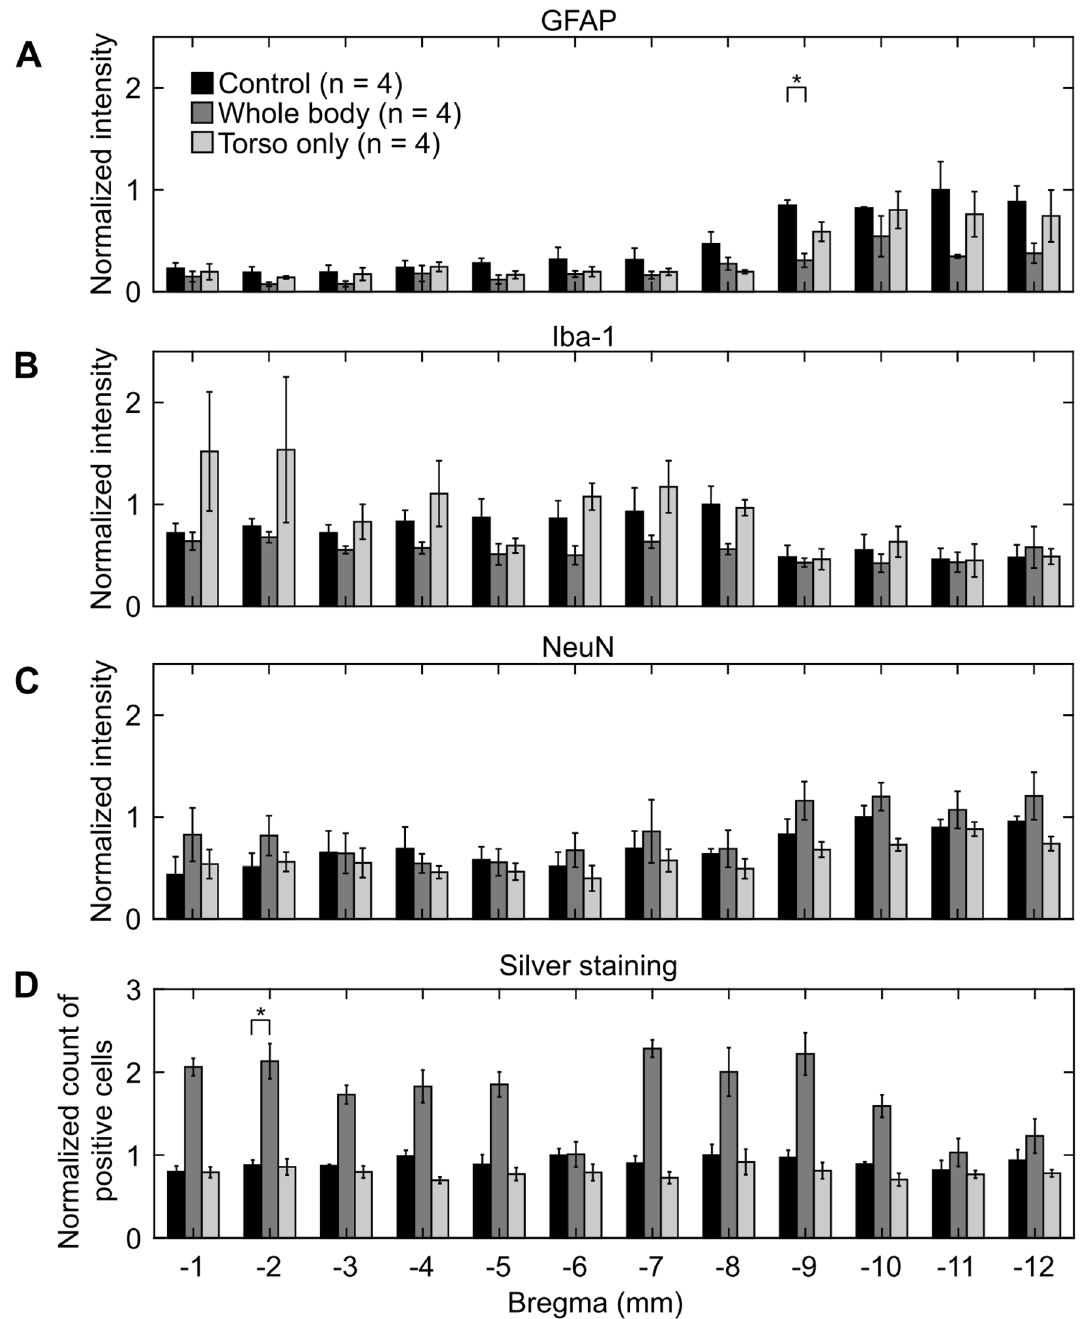
Figure 7. Changes in coronal brain slices due to whole-body or torso-only blast exposure in the indirect- mechanism study, as indicated by ( A ) GFAP-positive, ( B ) Iba-1-positive, ( C ) NeuN-positive, and ( D ) silver staining. Asterisks denote statistically significant differences (p < 0.05) between blast-exposed (n = 4) and control (n = 4) groups. The bar heights and vertical line lengths represent the mean and one standard error of the mean (SEM), respectively. At each brain-slice region for each group, we determined the mean and SEM using the corresponding brain-slice data. For each staining assessment, we then normalized the data for controls by the highest control value. Lastly, we normalized the data from blast-exposed groups (i.e., whole-body and torso-only) by the data from their respective controls at each region. We normalized the data for presentation purposes only. We conducted all statistical analyses using the raw data with their respective